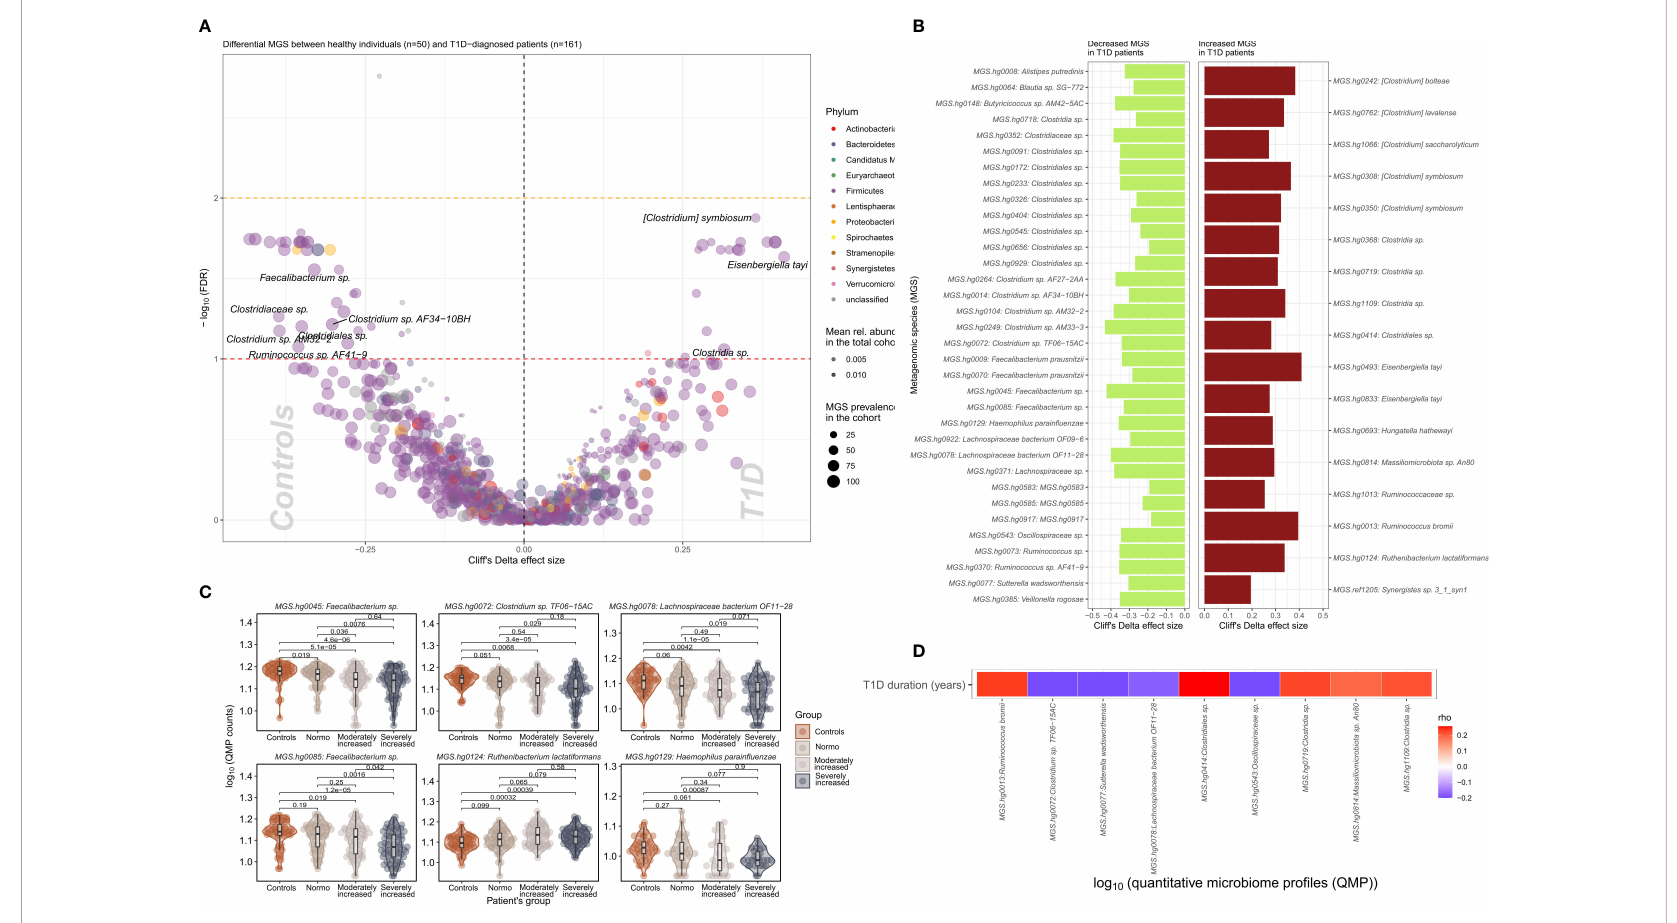
FIGURE 2 Differential bacterial abundance at metagenomic species (MGS) level, between T1D and healthy individuals. (A) Volcano plot showing difference in absolute abundance of metagenomic species (MGS) between T1D individuals (n=161) and the healthy controls (n=50). X-axis indicates Cliff ’ s Delta effect size; Y-axis represents FDR-corrected (negative log) p – values. MGS that associated positively with T1D have been depicted towards increasing direction of effects (right). MGS circle color depicts the corresponding annotated phylum. Circle size corresponds to the number of individuals in the cohort where the speci fi c MGS was found. Transparency of the circle corresponds to the average relative abundance in which each MGS is found within participants. (B) Signi fi cant contrasts in MGS abundance between T1D and healthy controls depicted with the bar length corresponding to Cliff ’ s Delta effect size: green for higher and red for lower MGS abundances within T1D individuals. (C) Differential absolute MGS abundance between T1D subgroups strati fi ed on levels of albuminuria. Individual distribution of the log10 transformed QMP counts (absolute abundance) is depicted for each MGS in violin and dot plots. Global distribution of the MGS counts for each T1D subgroup is depicted with a boxplot, indicating median value of the distribution with a horizontal line, fi rst and third quartile with the limits of the white rectangle and the upper and lower limits of the distribution with vertical bars. Signi fi cance for pairwise comparison between different study groups is indicated with p-value. (D) Signi fi cant correlations between T1D duration in years and absolute abundance of MGS (QMP counts) are depicted as a heat map. Positive correlations are shown in red and inverse correlations in